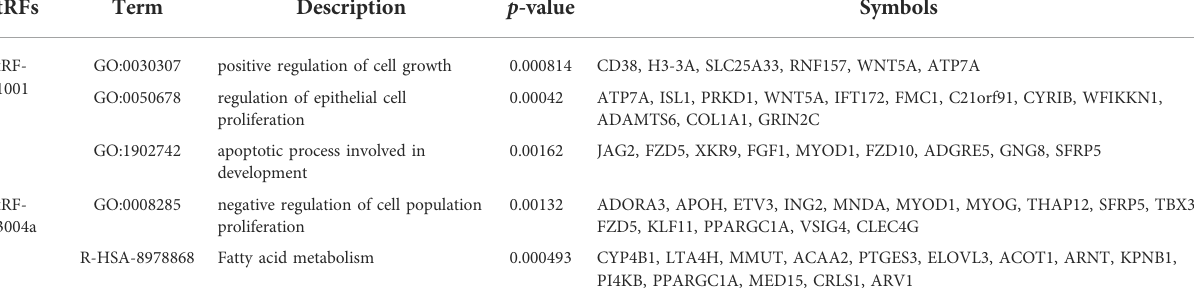
TABLE 1 Core functions and pathway factors of tRF-3004a and tRF-1001 target genes.